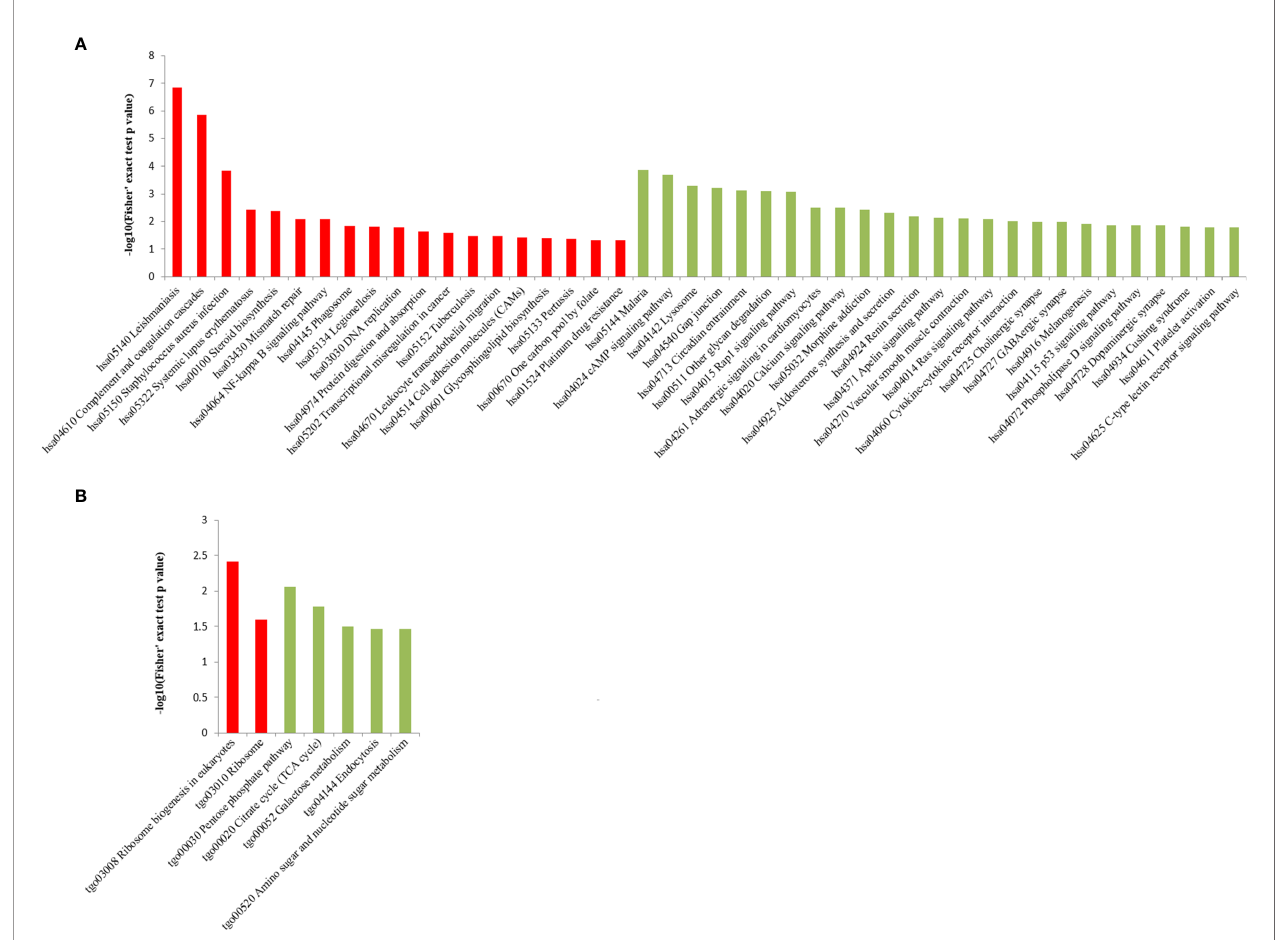
FIGURE 5 | KEGG pathway enrichment analysis of DEPs in the (A) HT vs . H and (B) HT vs . T groups. X-axis represents the signi fi cantly enriched KEGG pathways. Y-axis represents logarithmic corrected p values [ –